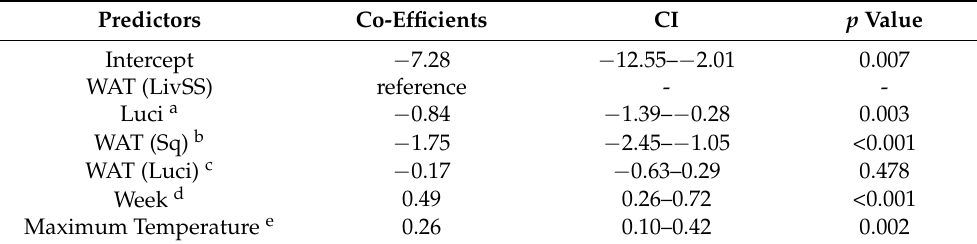
Table 4. Summary of the model coefficients, confidence intervals (CI) and p values for each predictor of mean catch of Lucilia cuprina . The mean catch model includes the catch of the target species and the catch of all species in each trap per week.